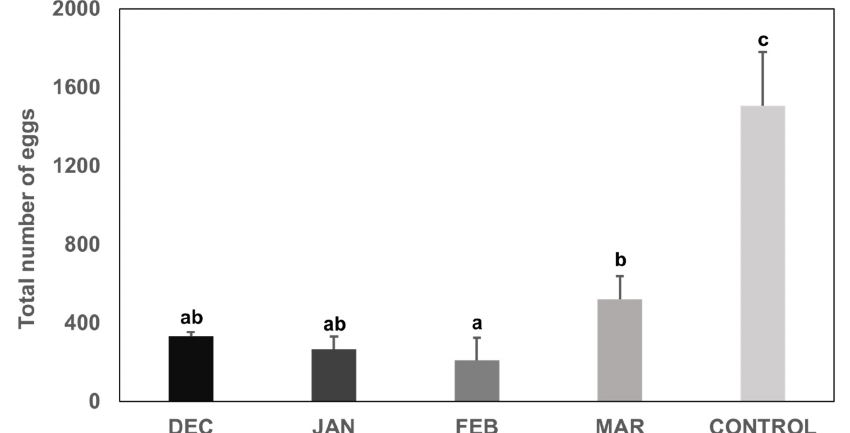
Figure 5. The total number of eggs (mean ± S.E. of 6 replicates) laid by Halyomorpha halys females ( n = 10) that overwintered in natural outdoor conditions until December 2020, January, February and March 2021 and were then transferred to 26 °C. A laboratory colony maintained at 26 °C was used as control. Different letters above bars indicate statistically significant differences ( p < 0.001).